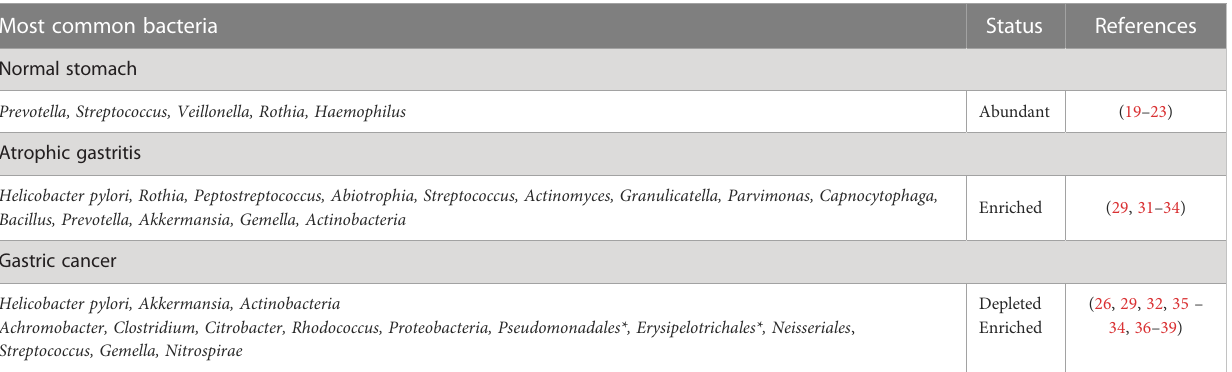
TABLE 1 Gastric dysbiosis throughout the Correa Cascade.